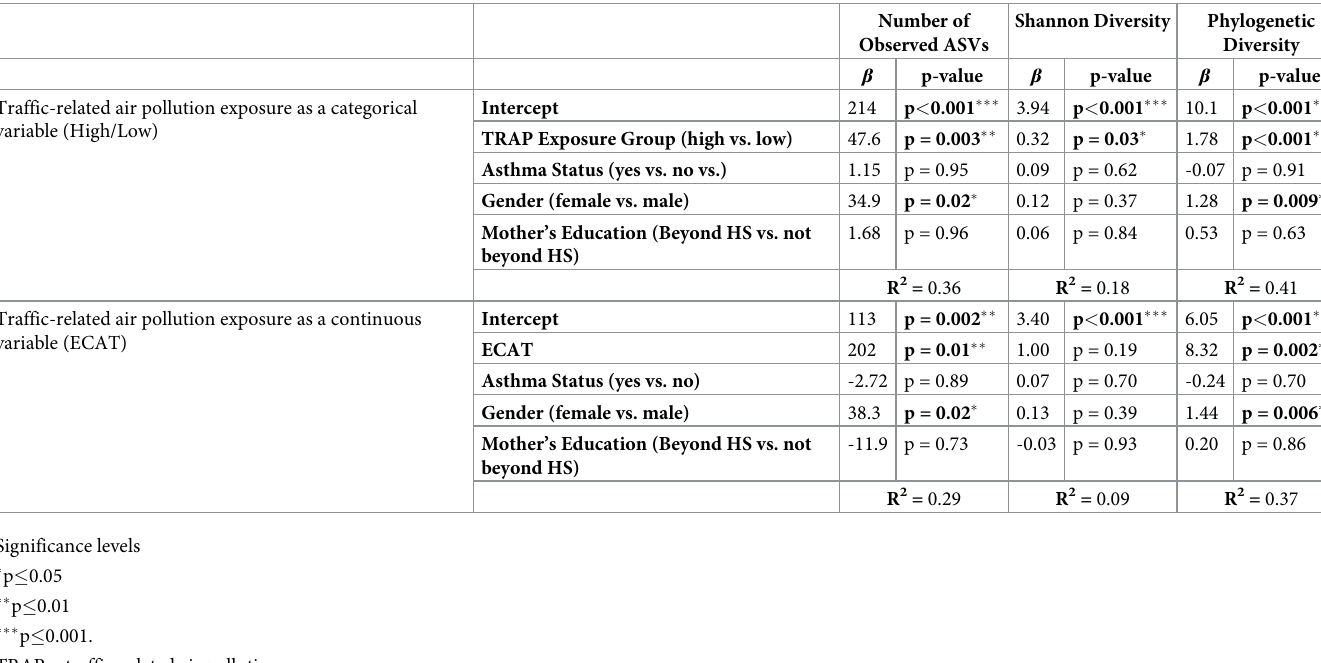
the sputum of asthmatics and non-asthmatics could be attributed to asthma status (p = 0.04). The Adonis test also indicated that 6% of the variance in the distance matrix between the sputum of male and female participants could be attributed to gender (p = 0.04). The homogeneity of disper- sion test showed no significant difference in the variances of the sputum samples from each asthma status group (p = 0.88) or from each gender (p = 0.46) indicating no confounding effect from a difference in variances. The Adonis test did not indicate that the variance in sputum between TRAP exposure groups could be attributed to TRAP exposure (p = 0.9). Relative abundance. According to the xdc.sevsample test, the distribution of major phyla did not differ in sputum between each TRAP exposure group nor each gender (p = 0.43 and p = 1.0, respectively). However, a significant difference in major phyla was found between asthma status groups (p � 0.001). These results are in agreement with the relative abundance bar plots (Figs 5 and S5). The relative abundance of phyla in sputum does not appear to differ between TRAP exposure group nor gender, but asthmatics appear to have more Bacteroidetes and fewer Proteobacteria .